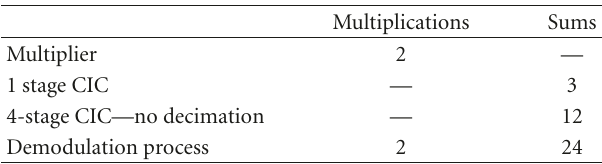
Table 1: Operations of the demodulator requested for each input sample.